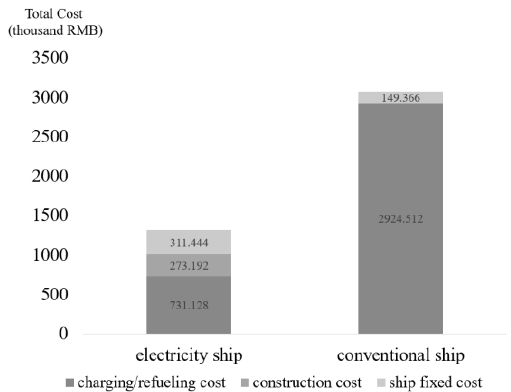
Figure 3. The comparison of total cost of scenarios using electric ships and conventional ships.